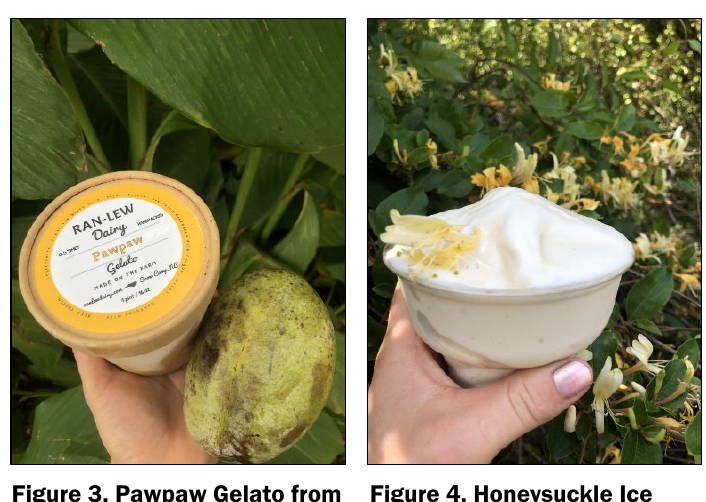
Figure 4. Honeysuckle Ice Cream from Ran-Lew Dairy